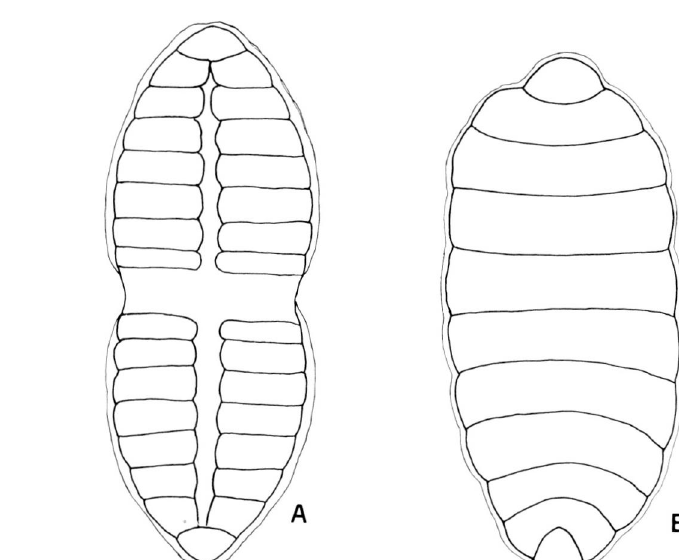
Fig. 5. - Schémas de la disposition des loculi à la surface distale des bothridies des genres Rhinebothrium (A) et Scalithrium (B).